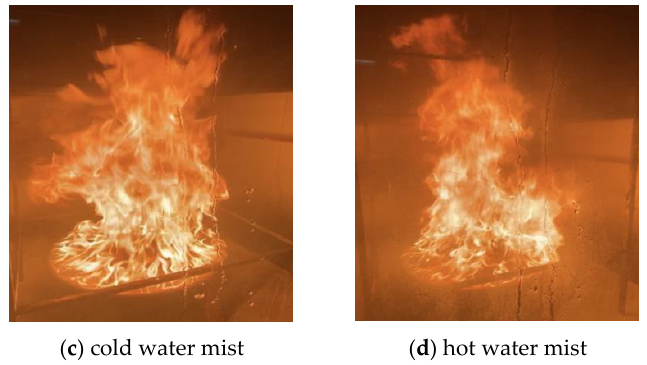
Flame diagram before the action of cold and hot water mist